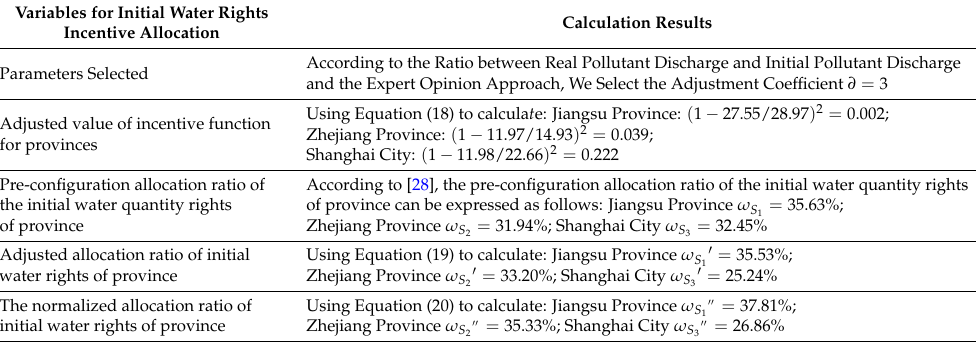
Table 3. The normalized allocation ratios of initial water rights incentive allocation (Taihu Basin, planning year